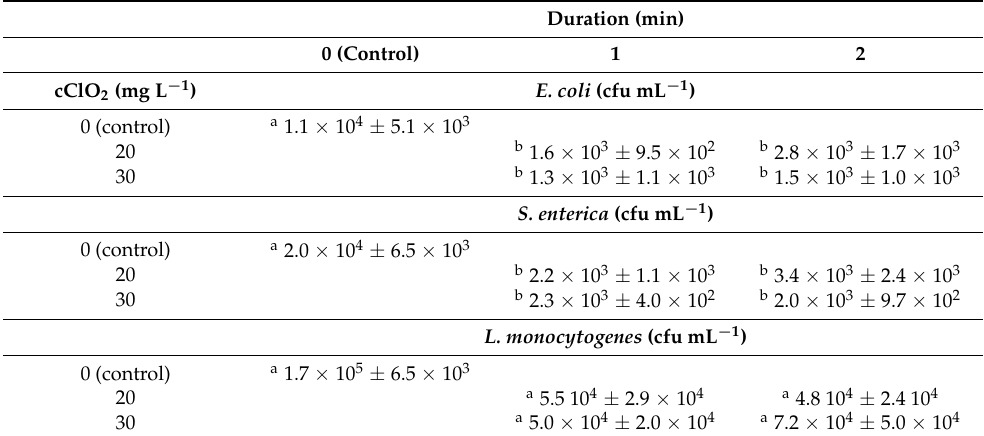
Table 1. Effects of ClO 2 treatments, varying in concentrations (cClO 2 ) and duration, on the inactiva- tion of E. coli , S. enterica and L. monocytogenes on iceberg lettuce leaves in washing water. Duration (min) 0 (Control) 1 2 cClO 2 (mg L − 1